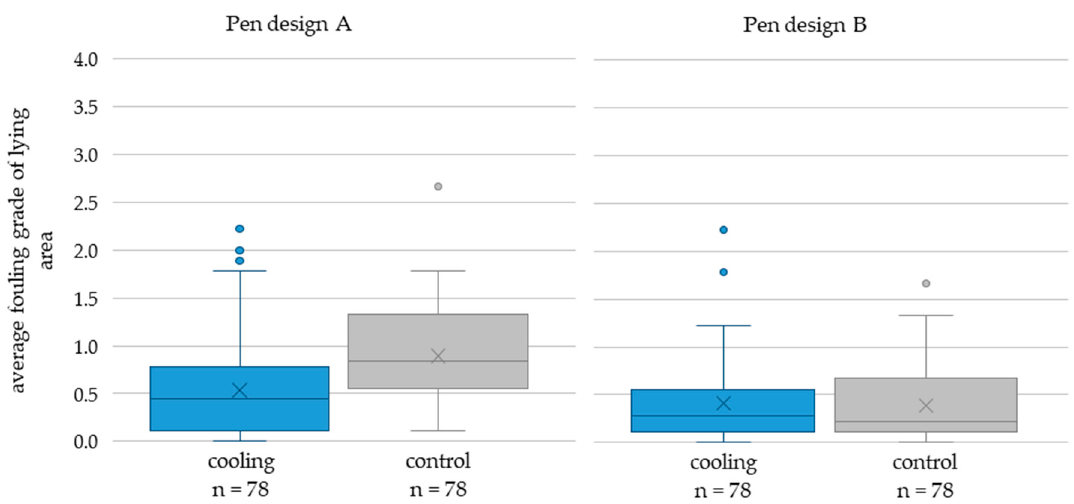
Figure 8. Scoring results of the fouling of the lying area for pen design A and B ( n = number of observations; usually 12 observations per period and pen, each boxplot contains data of two pens).